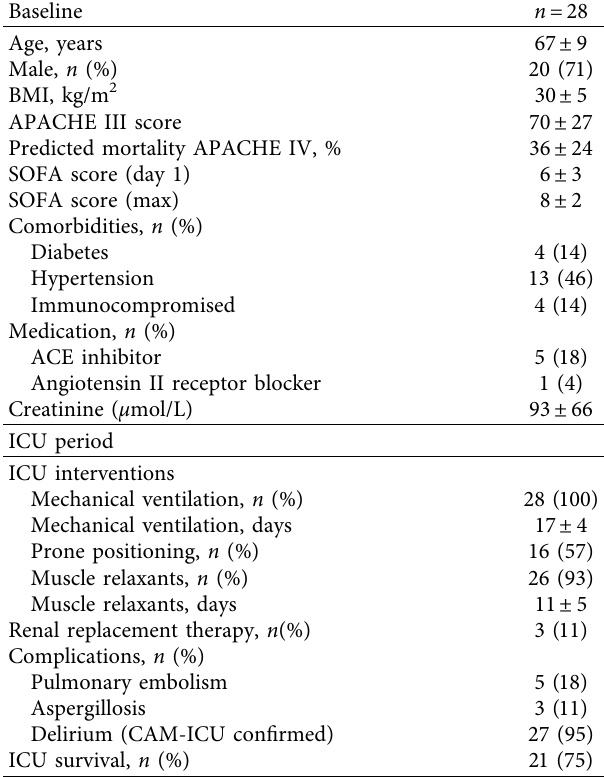
Table 1: Baseline and ICU